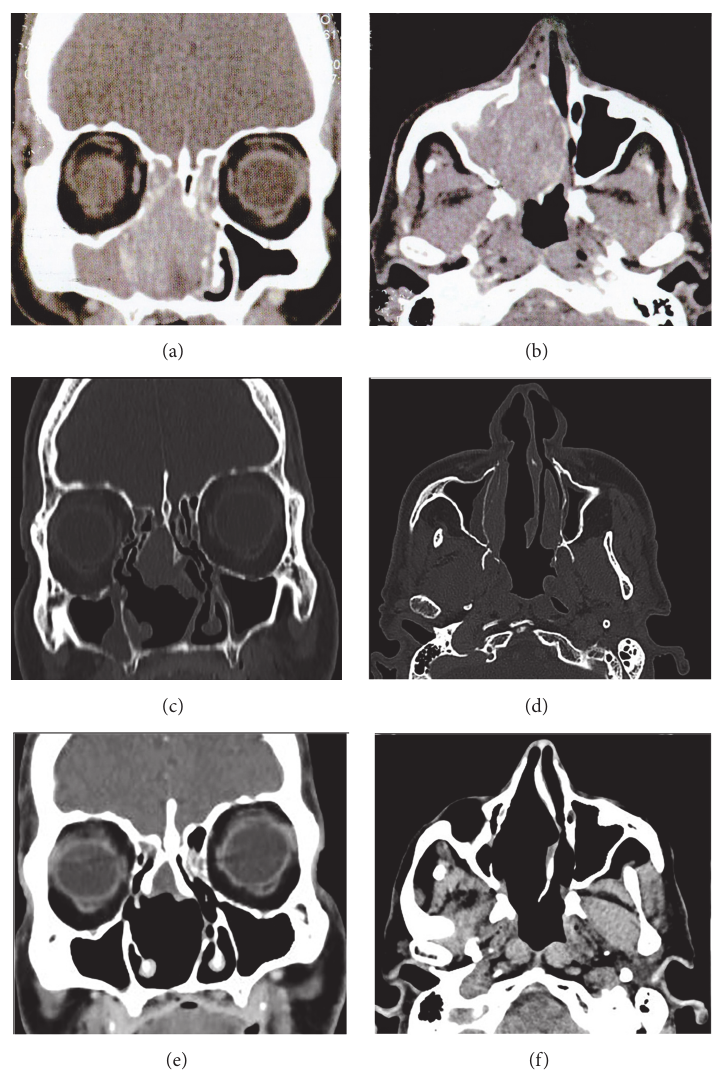
Figure1:(a)and(b):pretreatment:computedtomographyofthefacialsinuses.Presenceofasolidvoluminousmassextendingthroughoutthe rightnasalcavity,measuring3.8 × 3.1 × 5.1cmalongitslongestaxes.Thismassisinfiltratingtheleftnasalcavity,ethmoidalcells,andcribriform plate, causing erosion to the plate. (a) Coronal plane. (b) Axial plane. (c) and (d): midway through treatment: computed tomography of the facial sinuses. (c) Presence of a solid lesion affecting the ethmoidal cells, nasal cavity, and right sphenoid sinus, with the tumour extending as far as the floor of the sella turcica on the right, with erosion. No signs of pituitary involvement. Widening of the sphenoethmoidal recess due to infiltration of the tumour mass. Thickening of the mucosa occupying the maxillary sinuses bilaterally, principally on the right (coronal plane). (d) Lesion lodged in the right nasal cavity with deviation of the septum to the left (axial plane). (e) and (f): following treatment: computed tomography of the facial sinuses. Improvement of the sphenoid and right maxillary sinuses, with almost complete resolution of the lesions seen in previous exams. (e) Coronal plane. (f) Axial